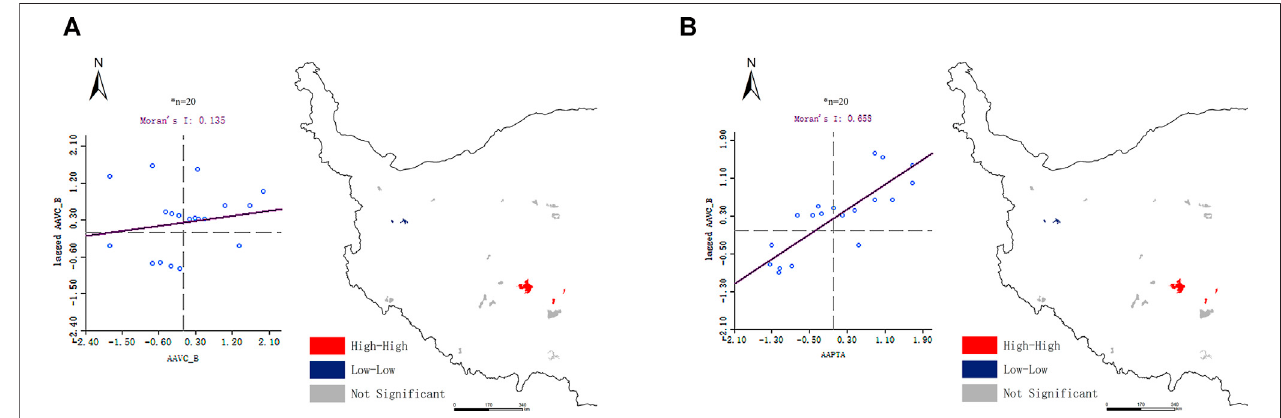
FIGURE 9 | Moran ’ s I index scatter plot and spatial aggregation LISA plot of lake water volume changes and the relationship between climate element changes in the studyarea. (A) Spatialautocorrelation ofregionallakewater volume changes; (B) Multivariate spatial correlation oftemperature, precipitation,and lake watervolume